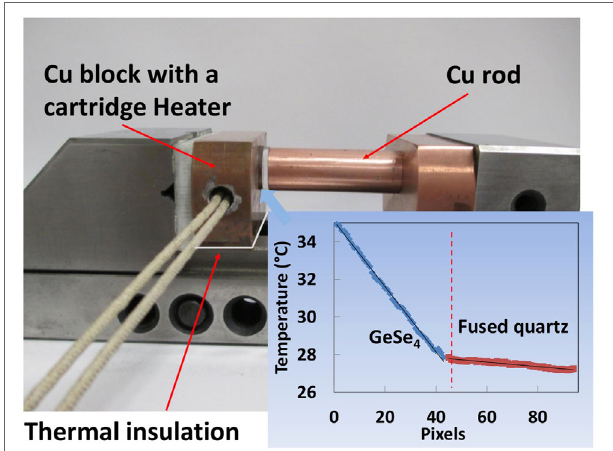
FIGurE 2 | Measurement setup for thin-disk samples and the measured temperature profile (~25 μ m per pixel) along the cross-plane direction of two disks (inset). Thermal compound and pressure are used to improve the thermal contacts of all